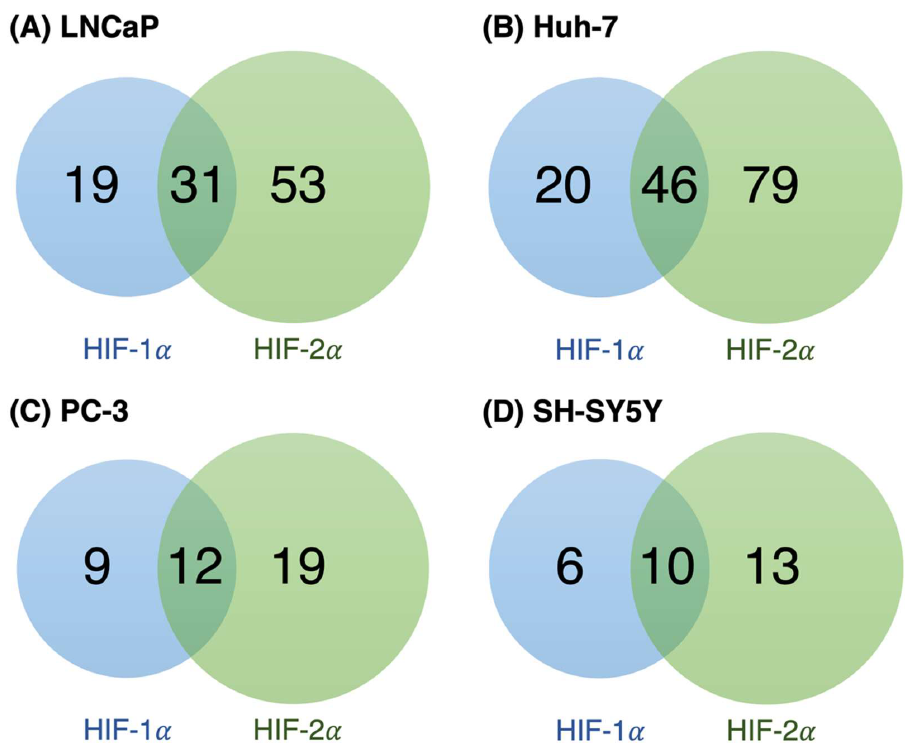
Figure 4. Venn diagrams showing the proportion of unique and shared HIF-1 α and HIF-2 α gene targets upregulated at 5% O 2 in ( A ) LNCaP, ( B ) Huh-7, ( C ) PC-3, and ( D ) SH-SY5Y cells. Hypoxia- inducible targets and their regulation by HIF-1/2 were identified by matching our data with the dataset from [75].